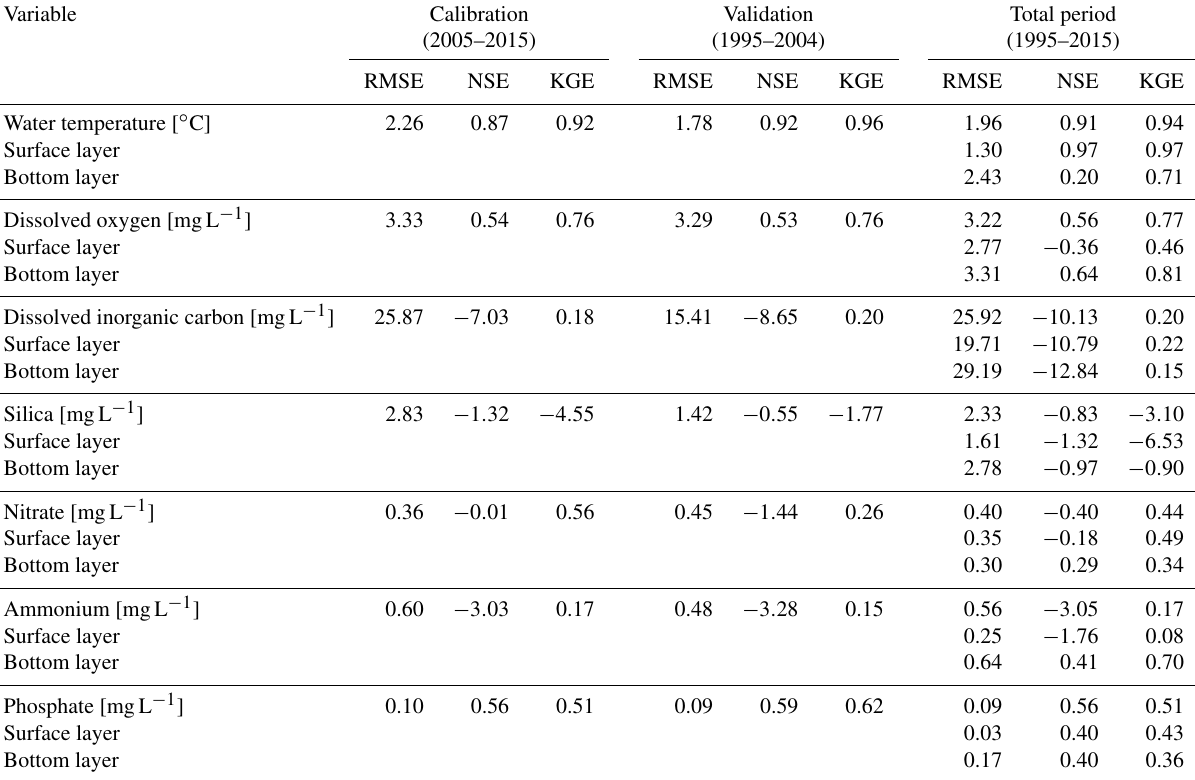
Table 2. Model performance for water temperature, dissolved oxygen, dissolved inorganic carbon, silica, nitrate, ammonium, and phosphate. During calibration and validation, only the total fits over all depths and time steps were calculated. Surface layers refers to a depth of 0m below water table and bottom layer to a depth of 20m below water table. Fits for surface and bottom layer during calibration and validation are not shown as the fit over the whole water column and over time were